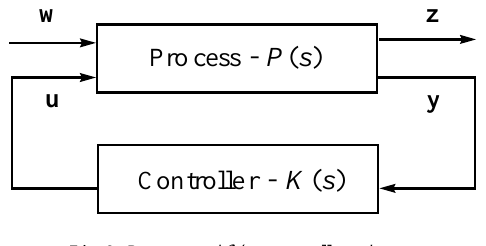
Fig. 3. Process and H ∞ controller